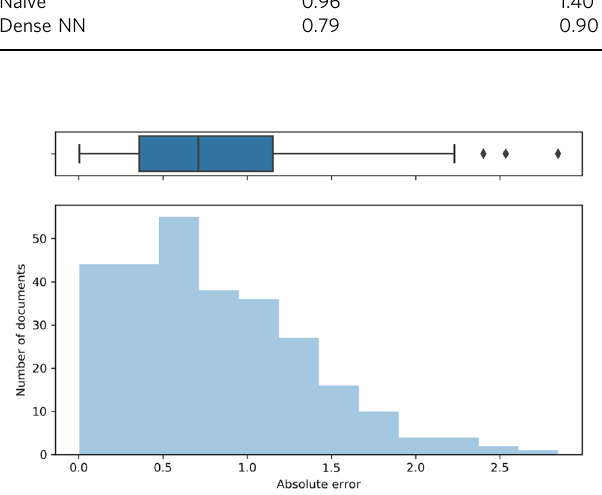
Fig. 6 Absolute error empirical distribution. 75% of the samples have an error of under 1.2, and the median error is 0.79.